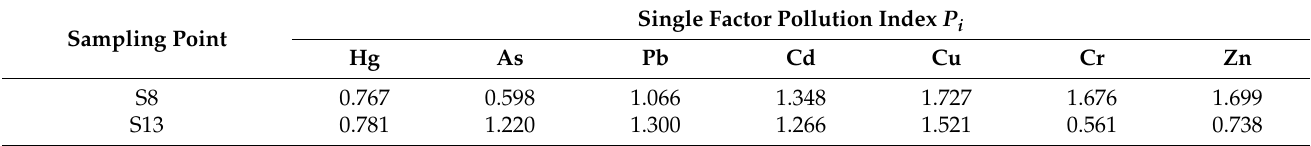
Table 8. Re-evaluation results of potential toxic elements pollution in selected soil samples ( n = 103) based on the single factor pollution index 1